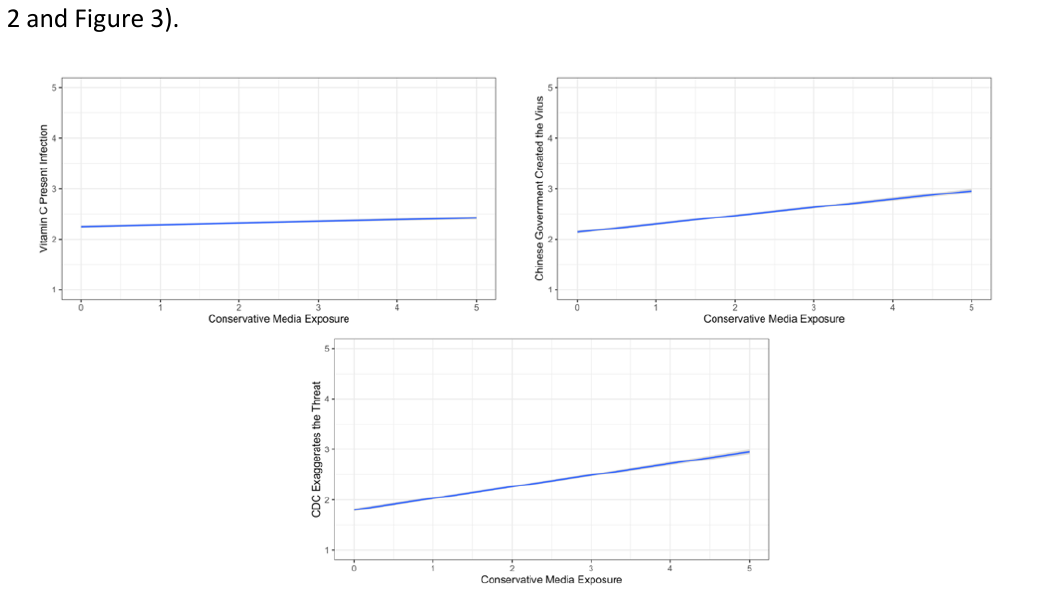
Figure 3. Associations between Conservative Print Media Exposure and